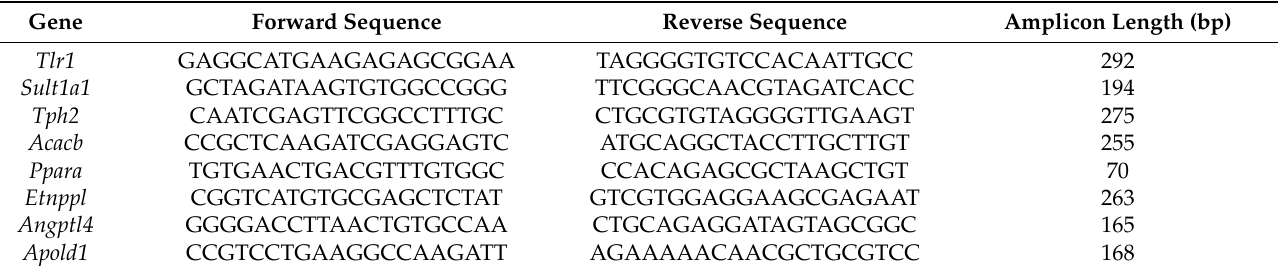
Table 1. Sequences of qRT-PCR